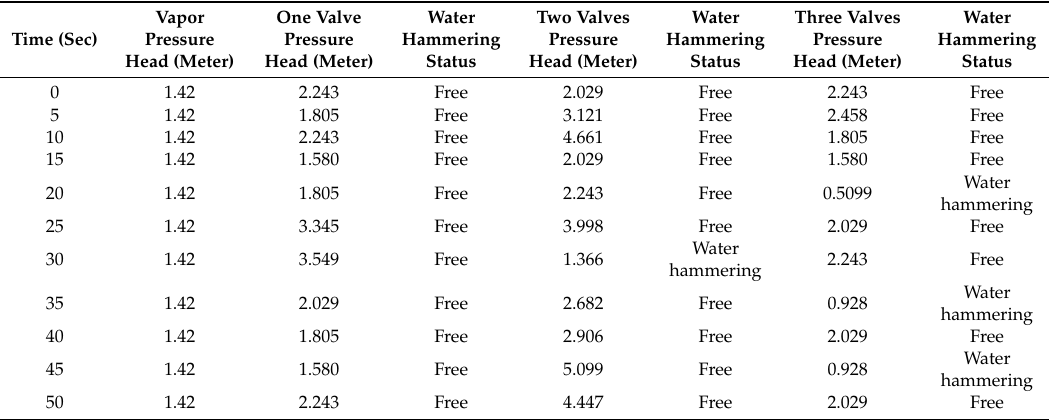
Figure 8. R 2 value of various algorithms. Table 3. Real-time data for comparing water hammering